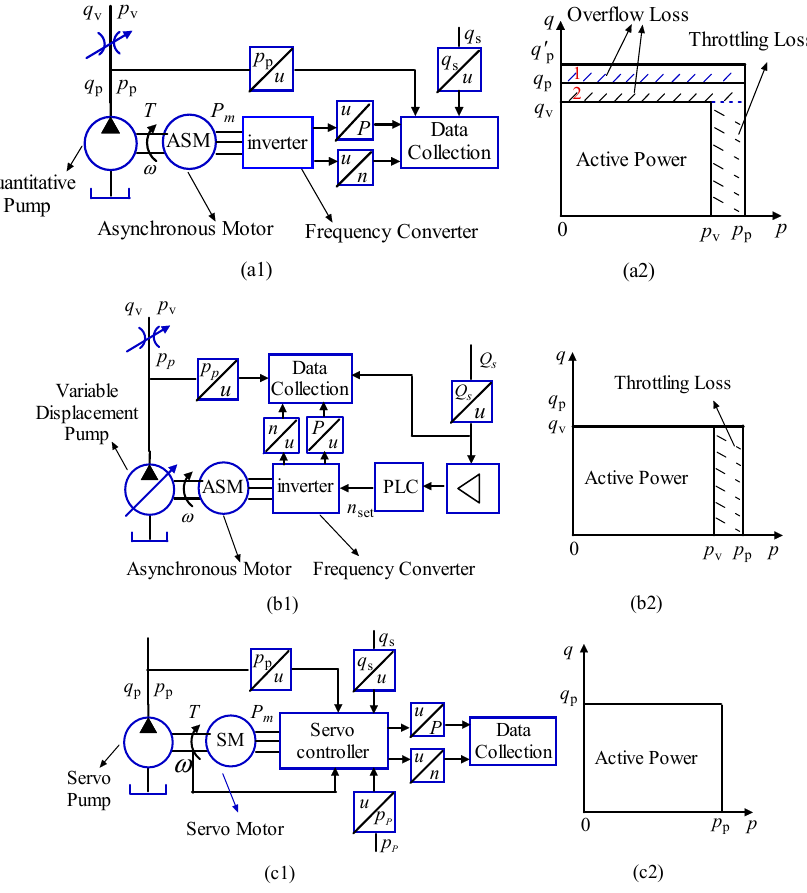
Figure 9. The control principle diagram and energy consumption analysis: (a1) The control system of the fixed displacement pump driven by asynchronous motor (ASM), (a2) Energy consumption distribution for Figure 9(a1) shown system, (b1) The control system of a variable displacement pump driven by asynchronous motor (ASM), (b2) Energy consumption distribution for Figure 9(b1) shown system, (c1) The control system of a servo pump driven by a servo motor (SM), (c2) Energy consumption distribution for Figure 9(c1) shown